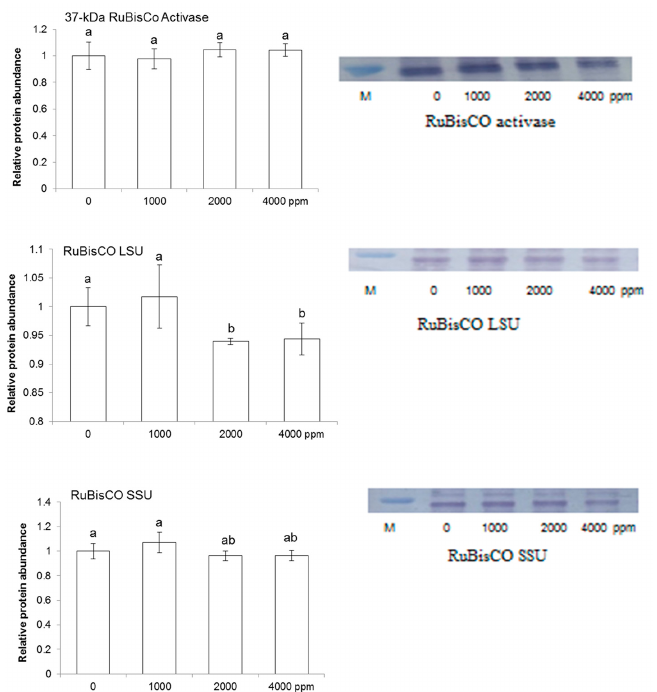
Figure 5. Effect of plant-derived smoke on RuBisCO subunits and activase enzymes in maize. Maize seeds were treated without or with 1000, 2000, and 4000 ppm plant-derived smoke for 6 h and sown in sand. Proteins were extracted from 4-days old maize shoot. ImageJ software was used to determine relative proteins intensities. Data are shown as means ± S.D. Different alphabets showing the statistical level of significance as determined by one-way ANOVA followed by Tukey’s multiple comparison ( p ˂ 0.05). In images, ‘M’ is used for marker.